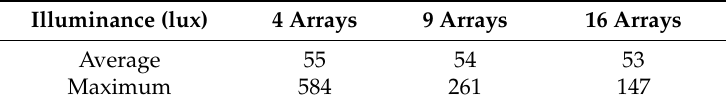
Table 5. Illuminance at ∅ 1/2 = 10 ◦ .